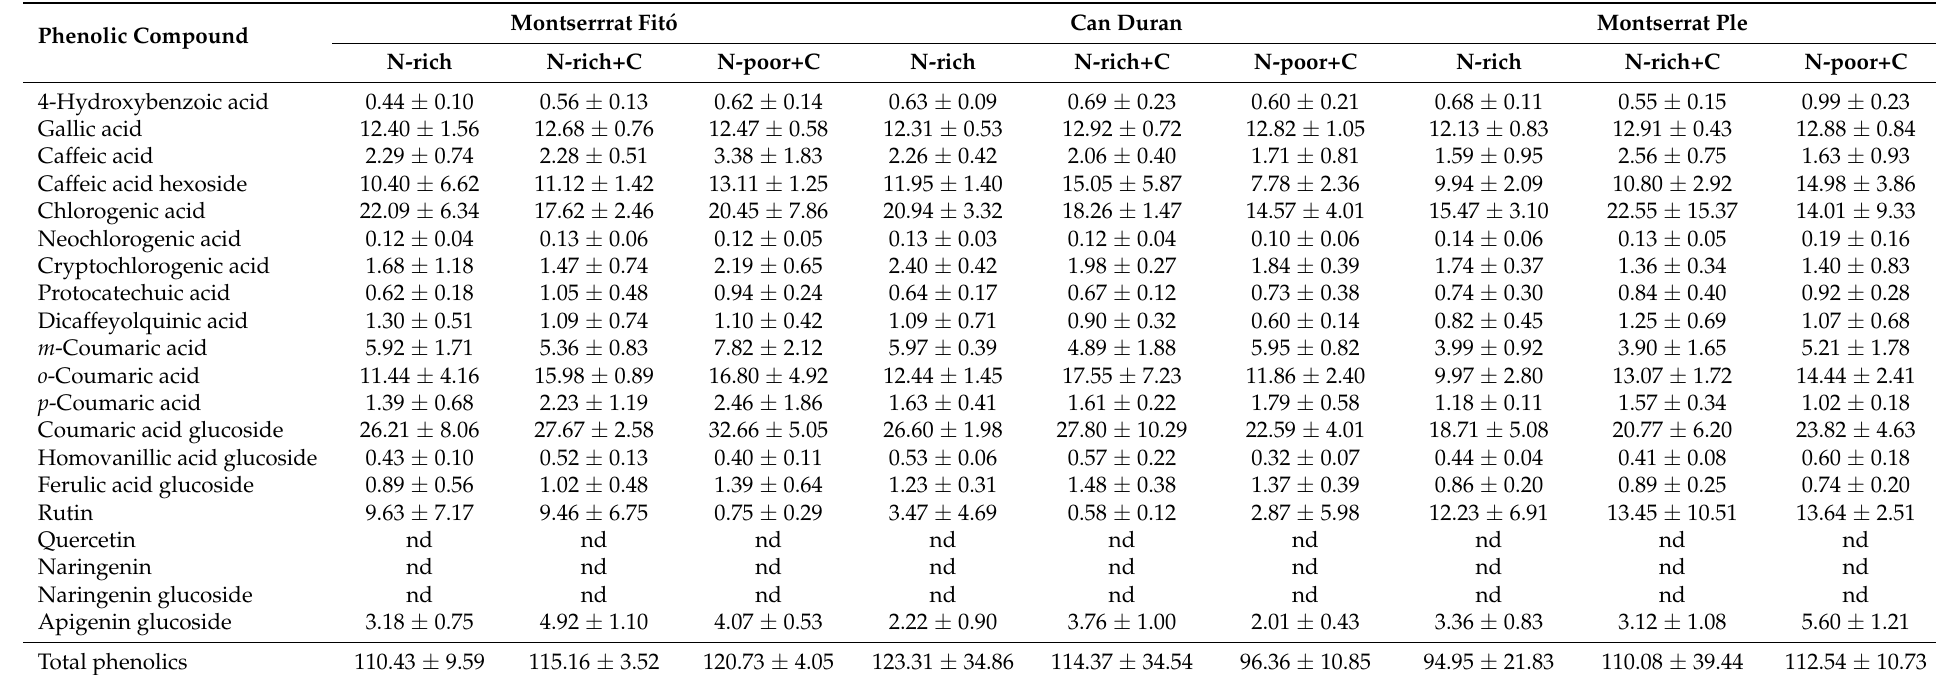
Table 8. Concentrations of the phenolic compounds (mg/kg) in the Montserrat tomatoes according to the fertilization